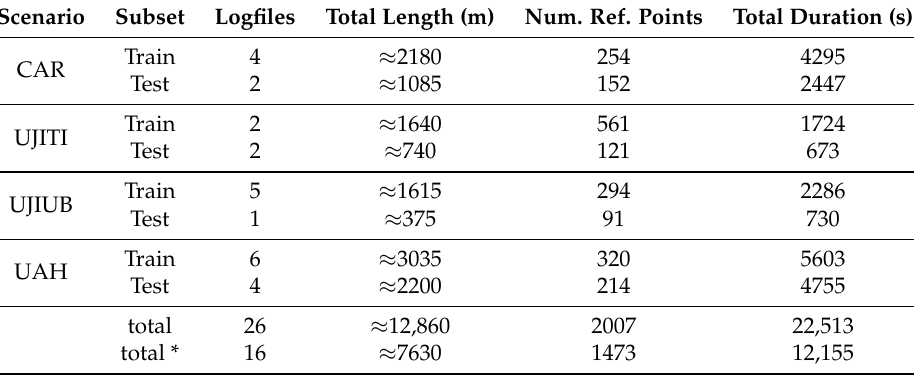
Table 2. Resume of the logfiles provided to 2016 IPIN